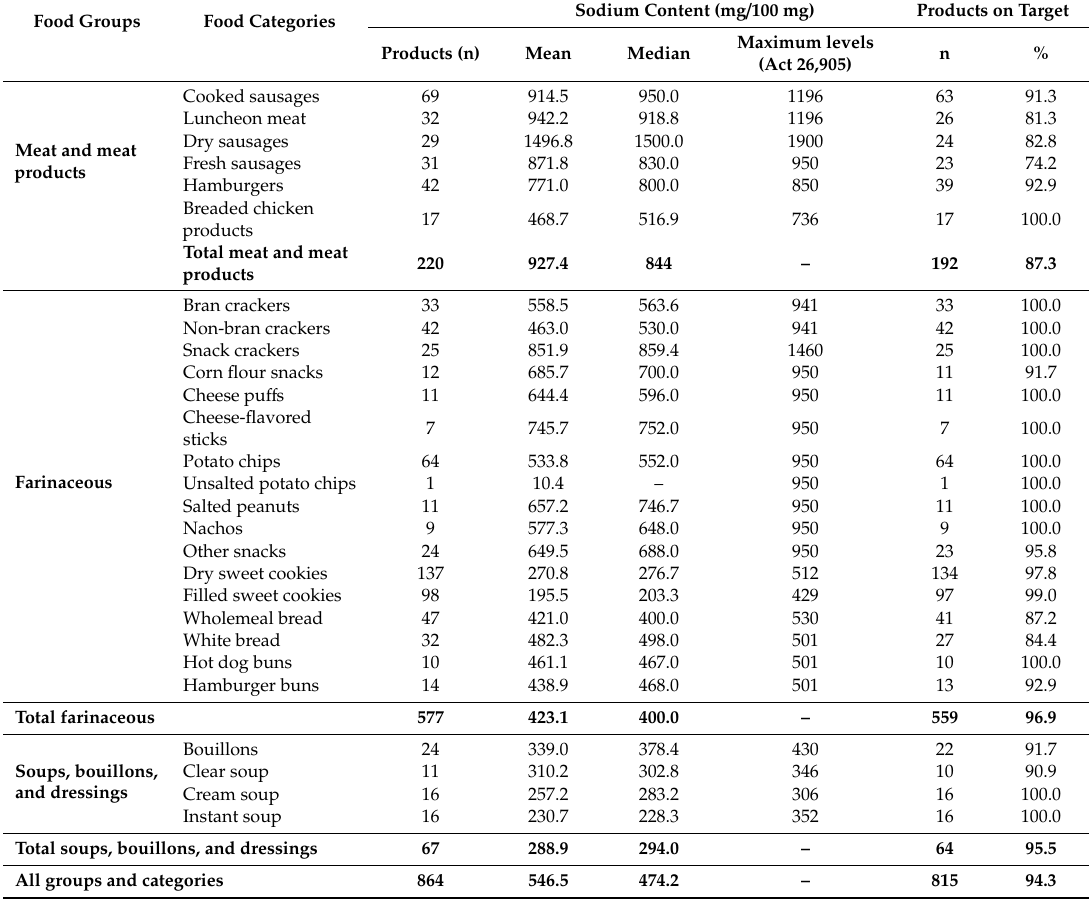
Table 2. Comparison of the observed sodium content with the maximum levels set forth by Act 26905 (n =